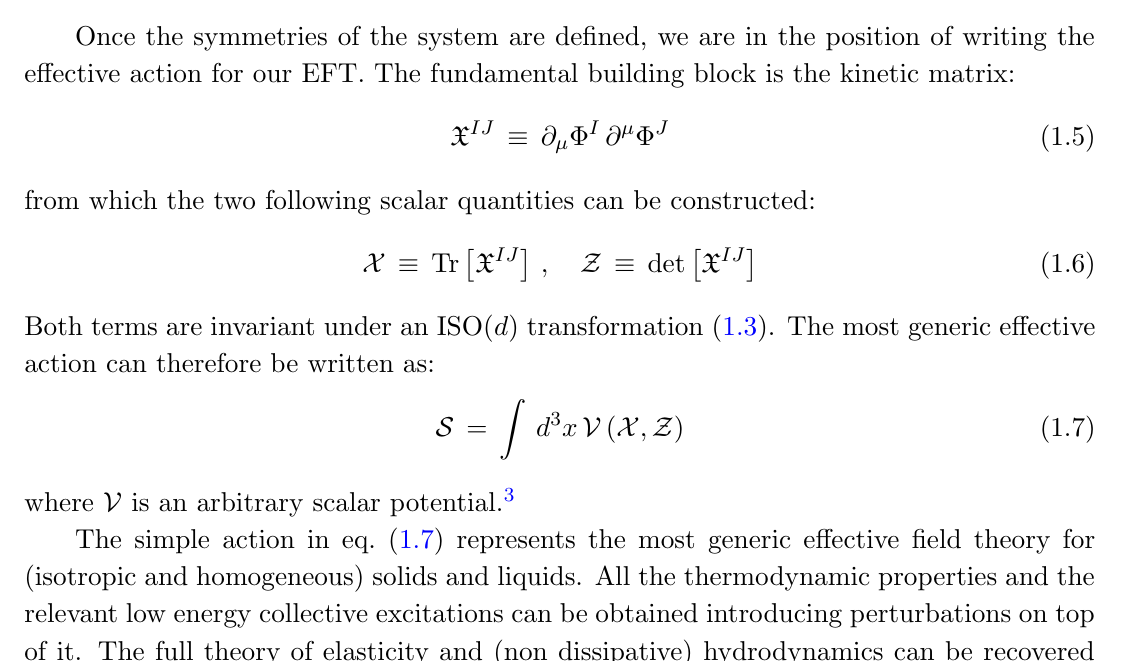
Figure 1 . The distinction between a solid and a liquid from the symmetry point of view. Both systems are invariant under ISO( d ) but the liquid is also invariant under a bigger symmetry group, volume preserving di(cid:11)eomorphisms. That is just the mathematical formulation of the statement that \liquids take the shape of the container in which they are